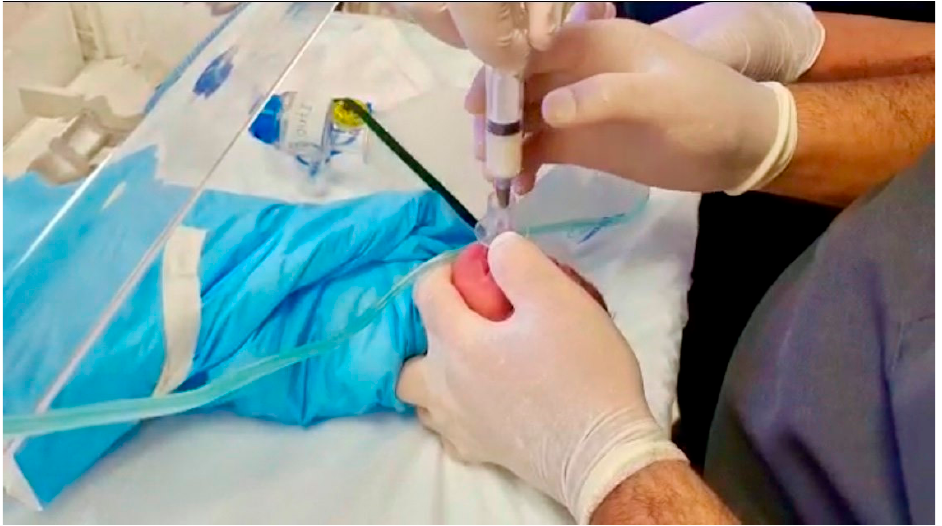
Figure 2. Master trainer using the SALSA technique to administer surfactant to a neonate.